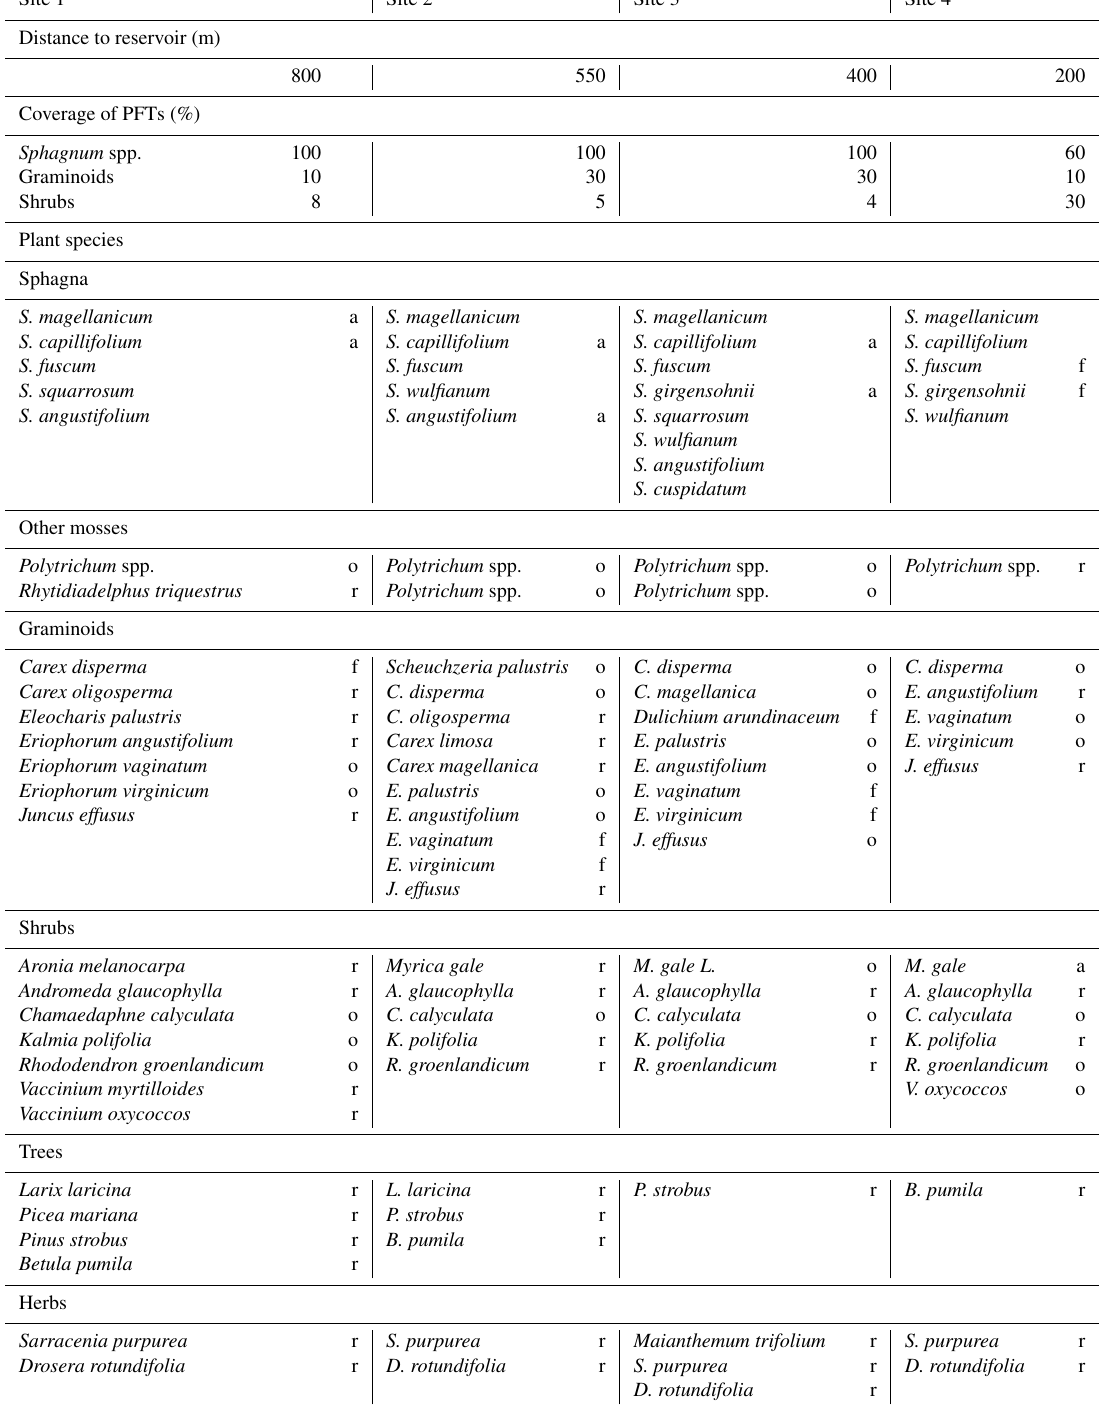
Table 1. Overview of the four sites’ distances to the water reservoir and the composition of the vegetation in terms of coverage (%) of plant functional types (PFTs) in hollows and the abundances of plant species (vascular plants and mosses, excluding liverworts and hornworts). Abundances are abbreviated as follows: “d” means “dominant” ( > 75%), “a” means “abundant” (51–75%), “f” means “frequent” (26–50%), “o” means “occasional” (11–25%), and “r” means “rare” (1–10%). Because Sphagnum mosses were very hard to distinguish in the field, we only determined the abundance of the most abundant Sphagnum species of each